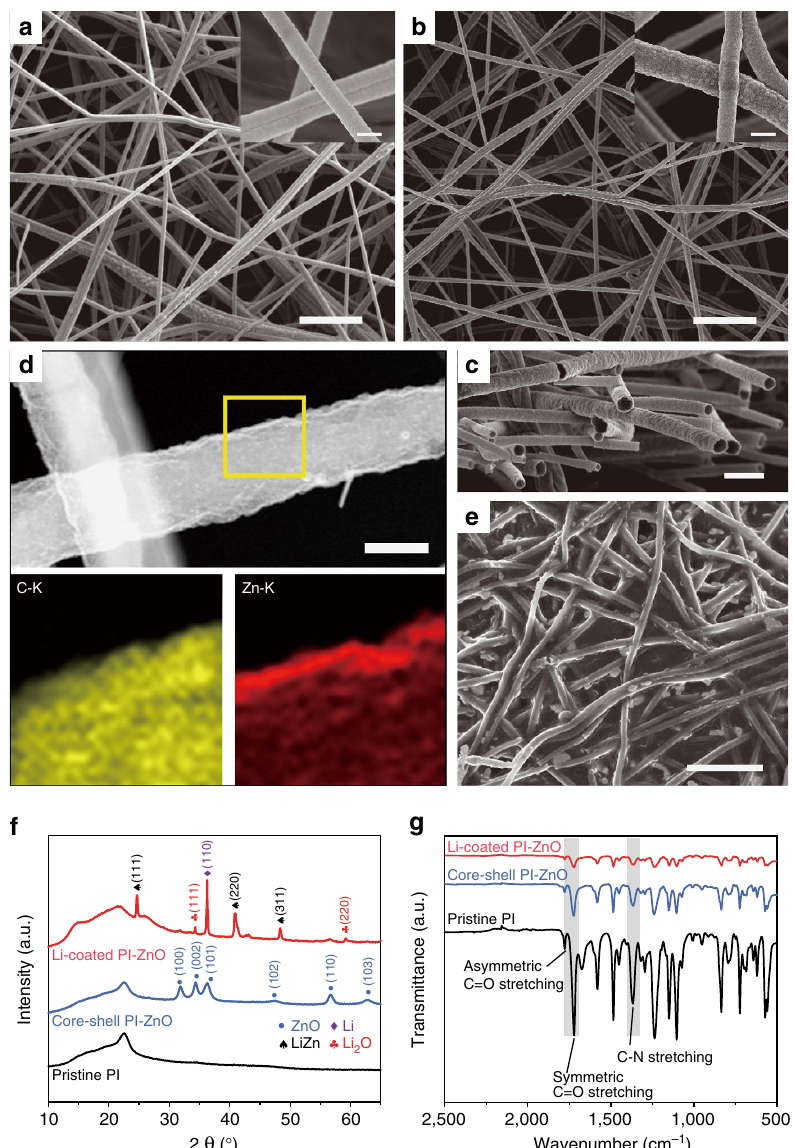
Figure 2 | Characterization of the Li-coated PI electrode. SEM images of the electrospun PI fibres ( a ) before and ( b ) after ZnO coating. Scale bars, 5 m m; insets scale bars, 500nm. ( c ) Cross-sectional SEM image of the core-shell PI-ZnO, where the conformal ZnO coating can be observed clearly from the contrast of the fibre cross-sections. Scale bar, 1 m m. ( d ) Scanning transmission electron microscopy (STEM) image of a single core-shell PI-ZnO fibre and the corresponding energy-dispersive X-ray (EDX) elemental mapping of C and Zn distribution. Scale bar, 200nm. ( e ) SEM image of the Li-coated PI matrix, showing the porous nature of the Li electrode. Scale bar, 5 m m. ( f ) XRD spectra of the pristine PI, the core-shell PI-ZnO and the Li-coated PI-ZnO matrix, where the Li-coated PI-ZnO exhibited the signals of LiZn alloy, Li 2 O and metallic Li. ( g ) Fourier transform infrared spectra of the pristine PI, the core-shell PI-ZnO and the Li-coated PI-ZnO matrix (Li was scraped away to expose the underlying matrix in order to obtain the signal). The characteristic peaks of PI remained after ZnO and Li coating, indicating the stability of the polymeric